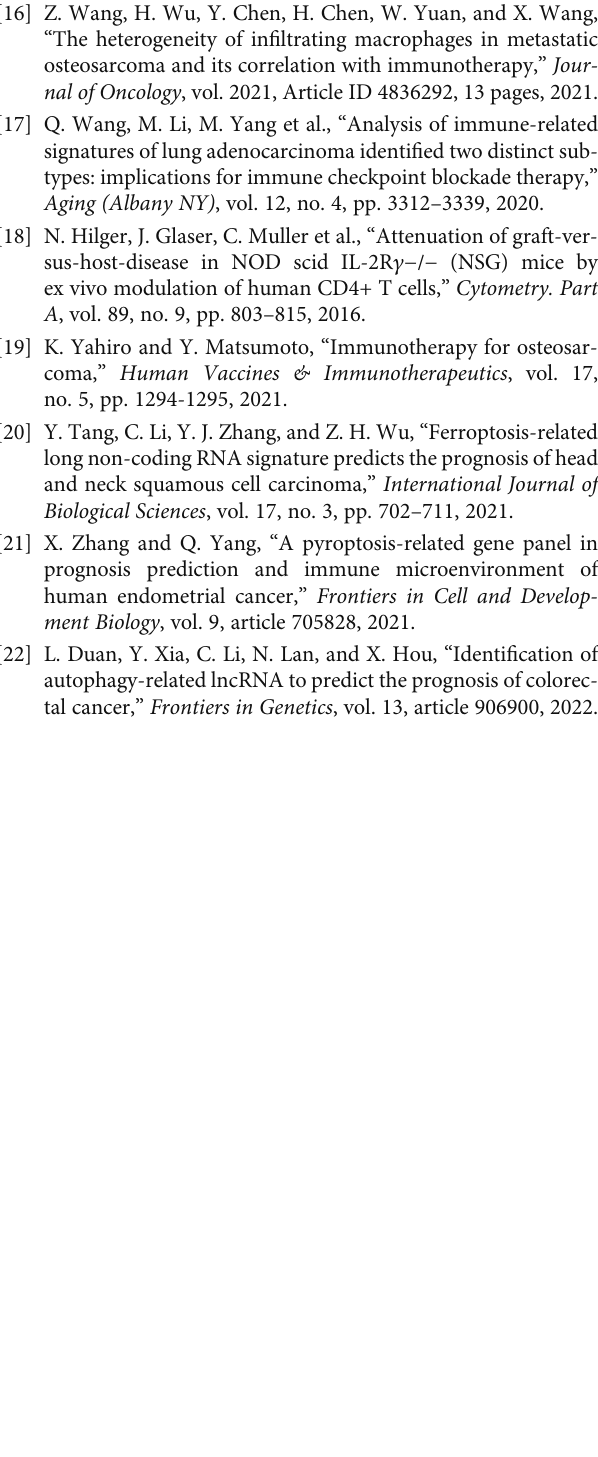
Supplementary Table: di ff erentially expressed genes between CD8 + cell clusters and remaining cells. (Supplementary